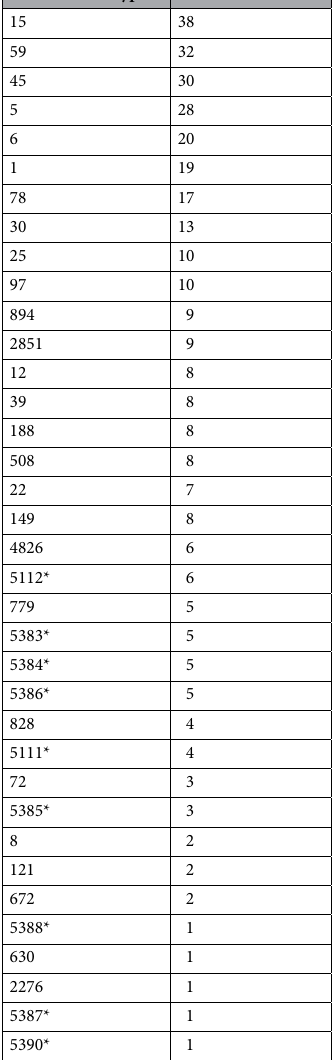
Table 1. Frequency of conventional 7-locus MLST profiles in the 340 included isolates. *MLST type newly registered from this